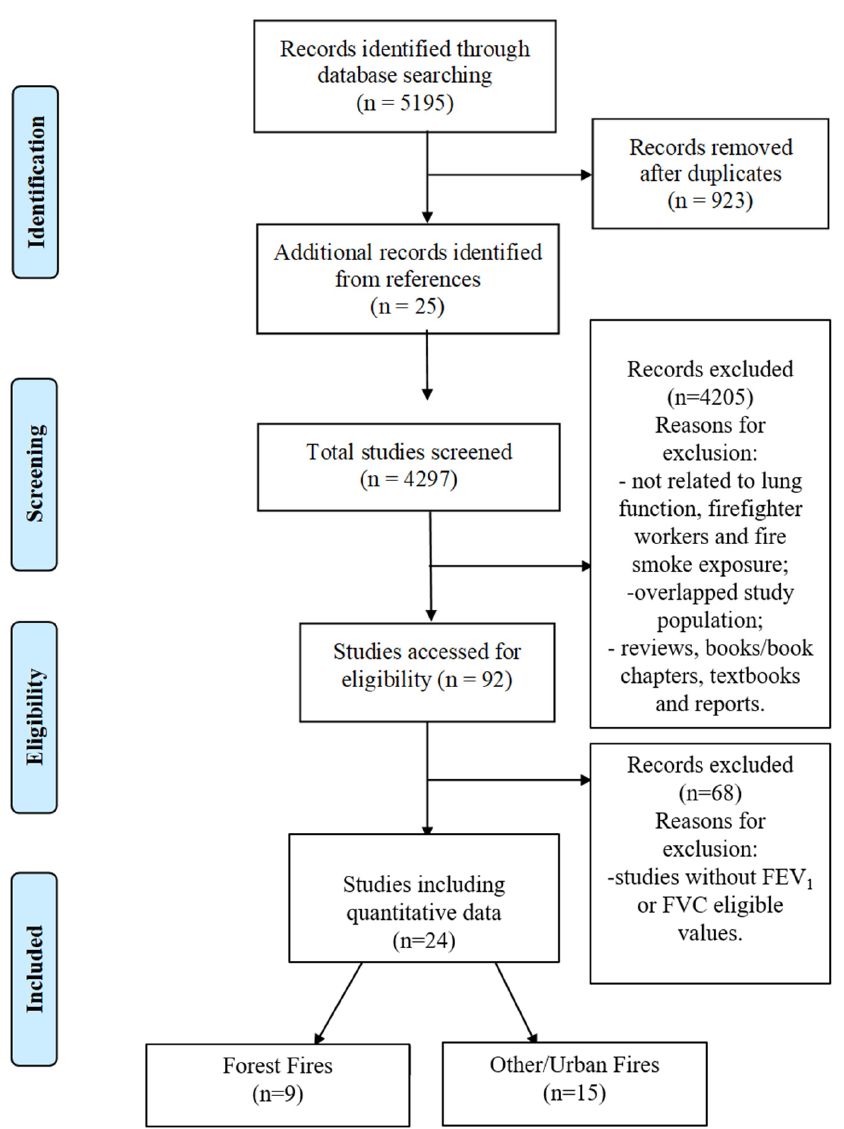
Figure 1. PRISMA flow diagram describing the search and selection procedures of the meta-analysis.